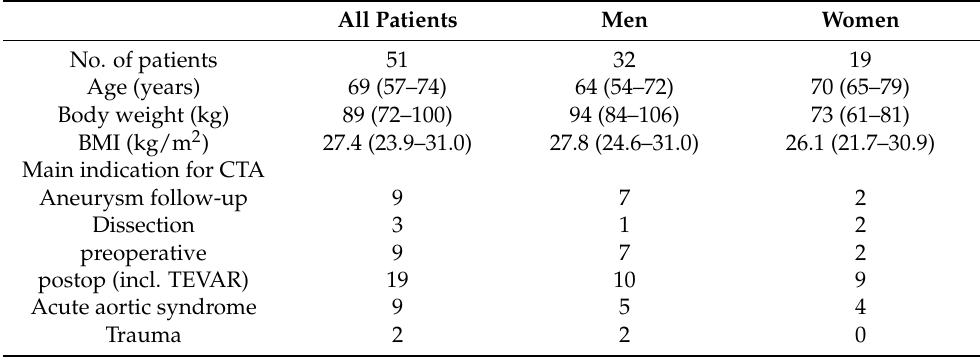
Table 2 data are shown as median (25–75 percentile) for age, body weight and BMI. BMI = body mass index. TEVAR = thoracic endovascular aortic